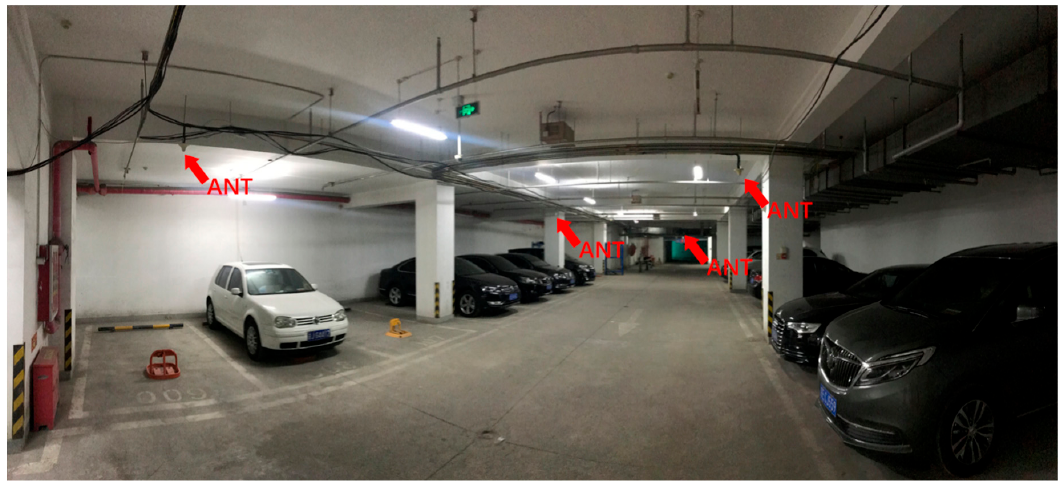
Figure 2. The real scene of the underground parking lot. ANT: antenna.